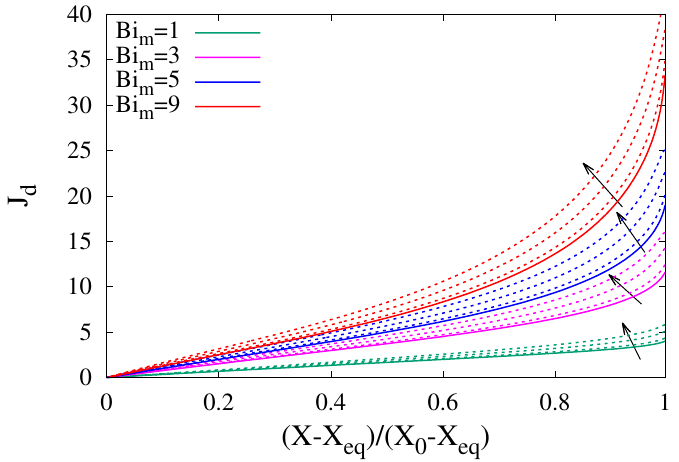
= β shell = 1. Continuous lines: 0 0